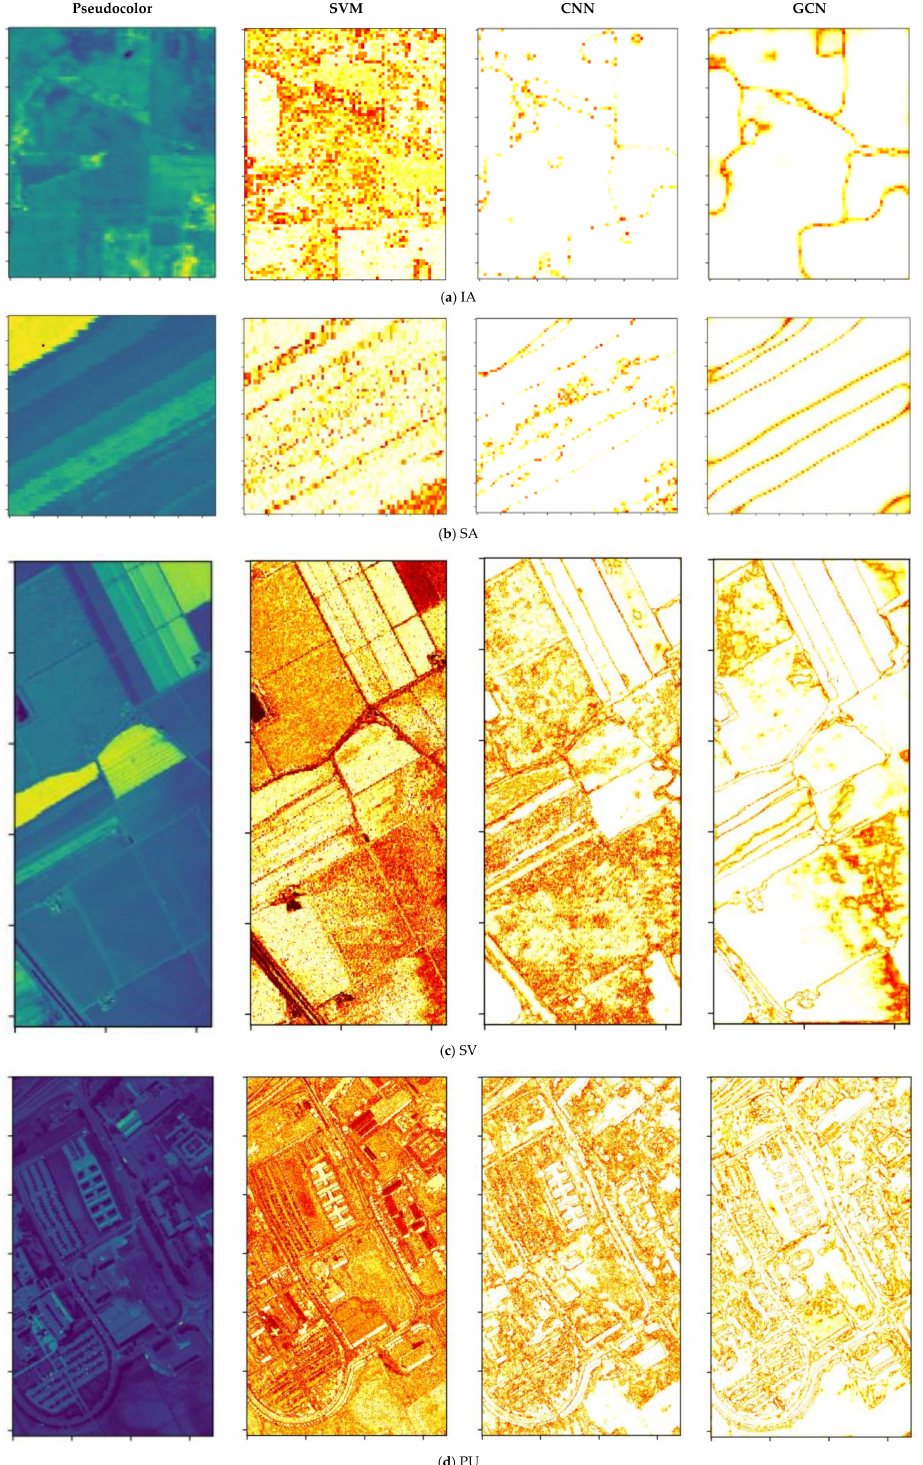
Figure 9. The probability maps of the presented GCN and its competitors in the 1st run for four real hyperspectral datasets, i.e., ( a ) the IA dataset, ( b ) the SA dataset, ( c ) the SV dataset, ( d ) the PU dataset, corresponding to the experiment with five random runs. Note that the deeper the color, the weaker the